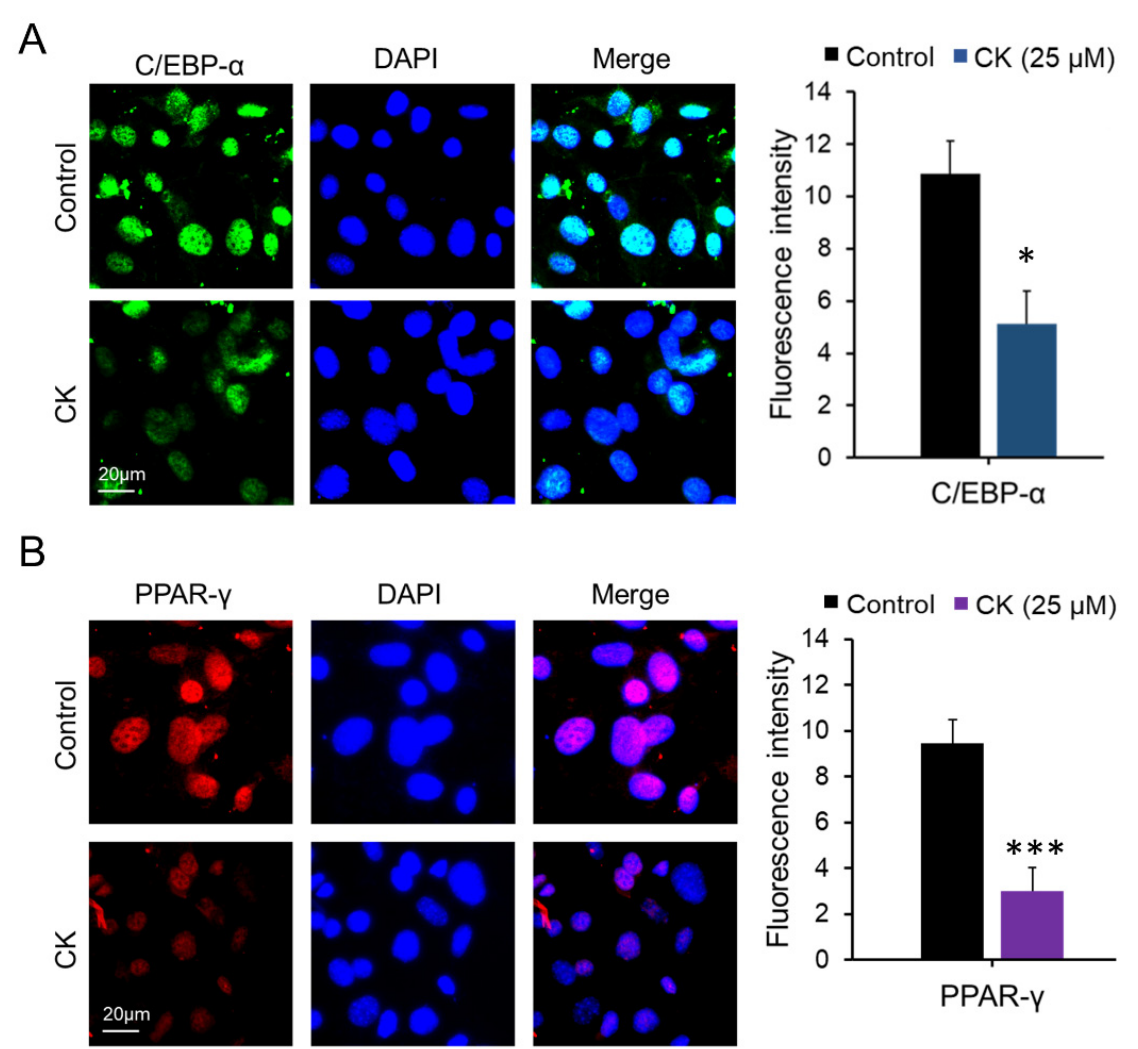
Figure 3. Effect of CK on the expression of key adipogenic proteins in 3T3-L1 cells. During 8 days of differentiation, 3T3-L1 cells were stimulated with 25 μ M CK, and ( A ) C/EBP α and ( B ) PPAR- γ proteins were measured via immune cell staining (ICC). Fluorescence intensity was measured using Image J histogram software. The data were expressed as mean ± SD ( n = 3) and analyzed using Student’s t -test. Control group: differentiated group; CK: CK treated group. *: p < 0.05, and ***: p < 0.001 compared to control. Control: differentiated group.